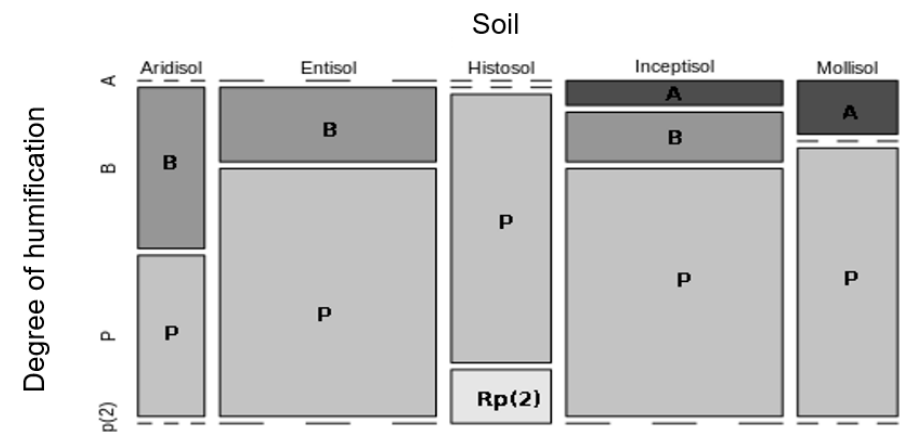
Figure 5 : Distribution of the degree of humification in the different soil